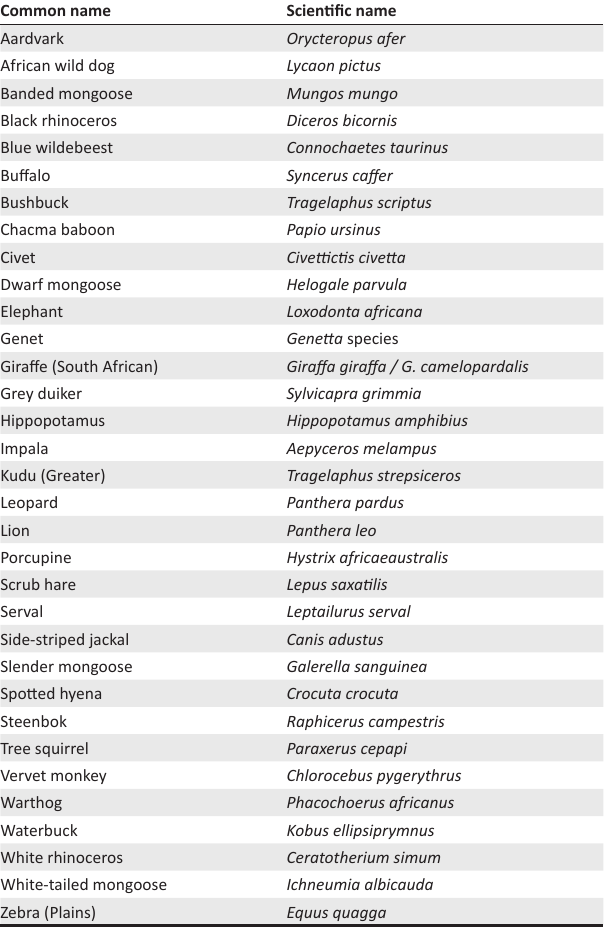
TABLE 1: Common and scientific names of all mammals observed in the study area by means of camera trapping. Common name